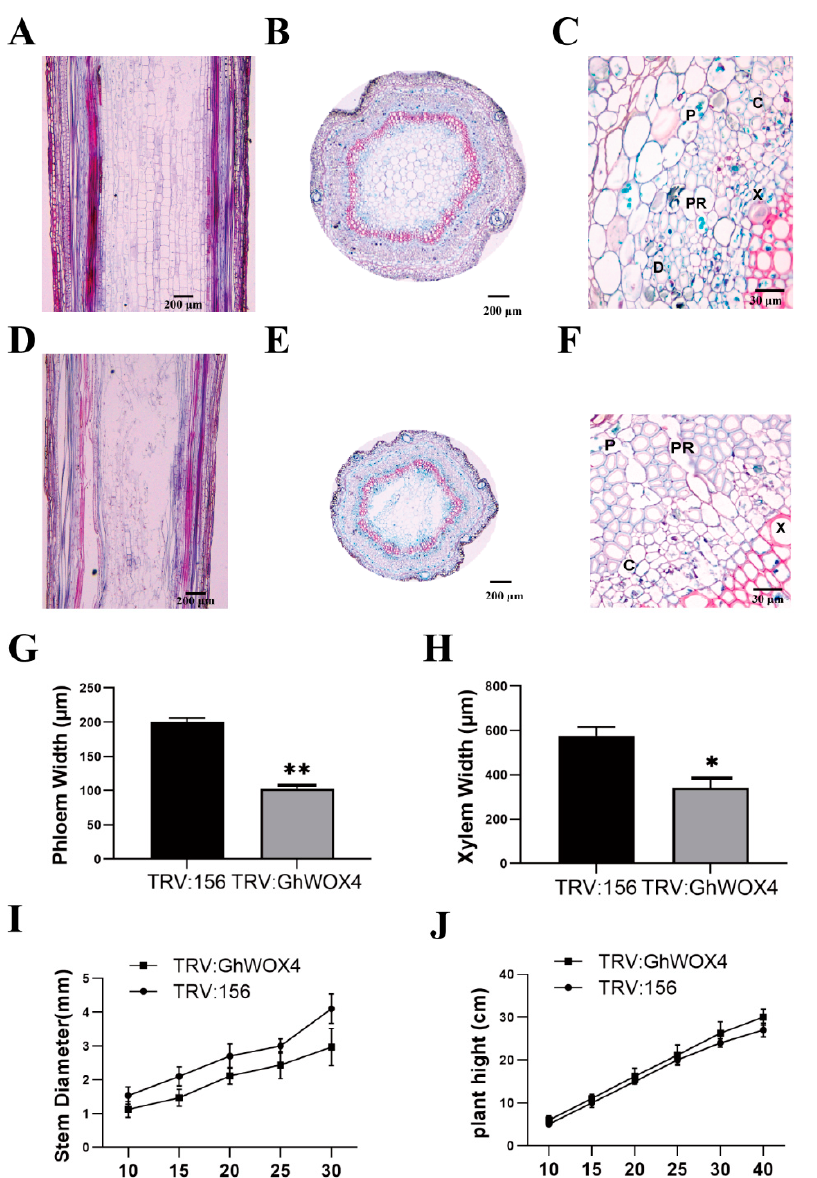
Figure 5. Reduced vascular region and cambial division in TRV:156 (control) and TRV:GhWOX4 (VIGS). ( A ) Stem-control (CK) longitudinal cross-section. ( B ) Stem (CK) transverse cross-section. ( C ) Anatomical close up of CK plant. ( D ) Stem (VIGS) longitudinal cross-section. ( E ) Stem (VIGS) transverse cross-section. ( F ) Anatomical close up of VIGS plant. ( G ) Phloem width in the stem of CK and VIGS plant. ( H ) Xylem width in the stem of CK and VIGS plant. ( I ) Stem diameter comparison of CK and VIGS plant. ( J ) Plant height comparison of CK and VIGS plant. Bar = 200 µm or 30 µm. C, cambium; P, phloem; X, xylem; PR, phloem ray; D, division activity. The data represent the means ± SE from three independent experiments, t-tests: * p < 0.05, ** p <